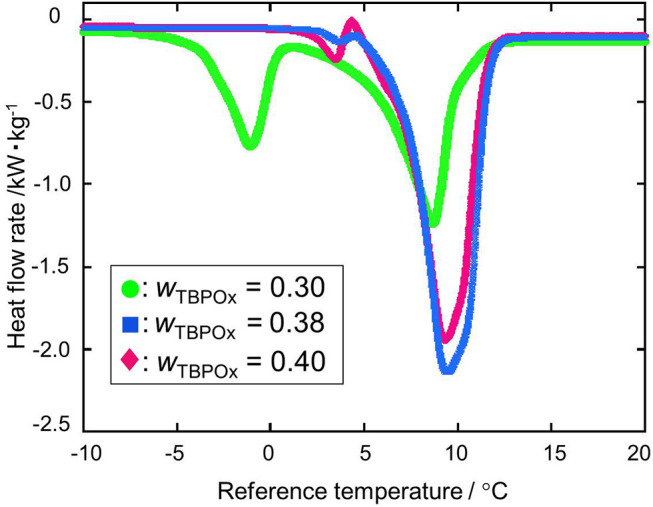
The heat flow rate at the mass fractions 0.30, 0.38, and 0.40: green •, wTBPOx = 0.30; blue ■, wTBPOx = 0.38; red ♦, wTBPOx = 0.40.